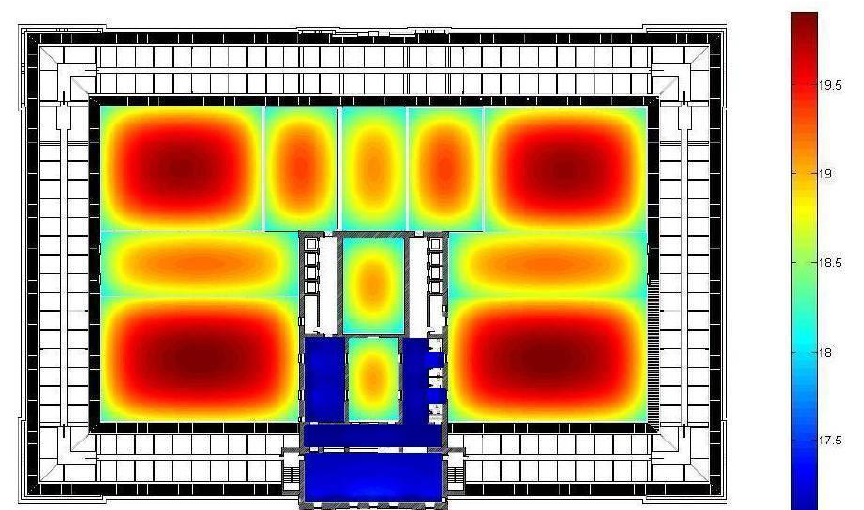
Figure 19. Temperature distribution in deg. C, during winter, inside the retrofitted spaces.